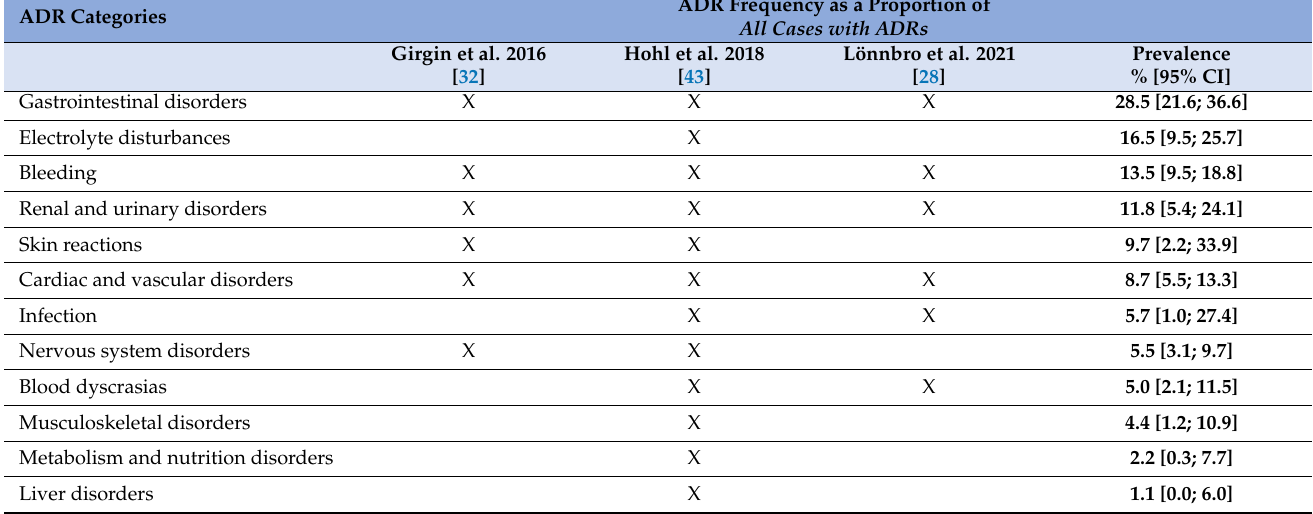
Abbreviations: ADR = adverse drug reaction; CI = confidence